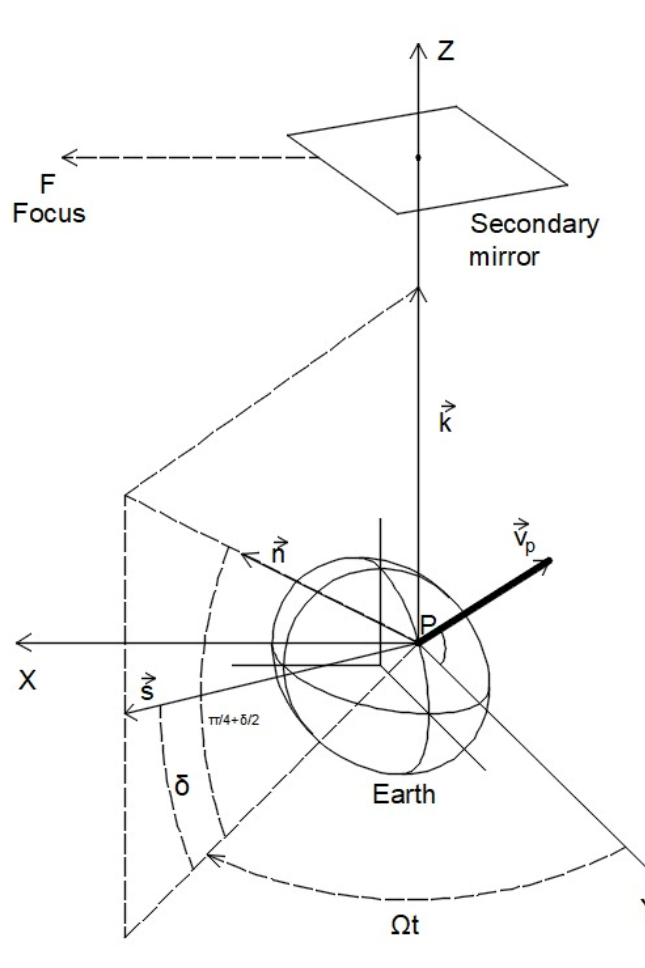
Figure 1. Astronomical fundamentals of heliostatic illuminator motion.